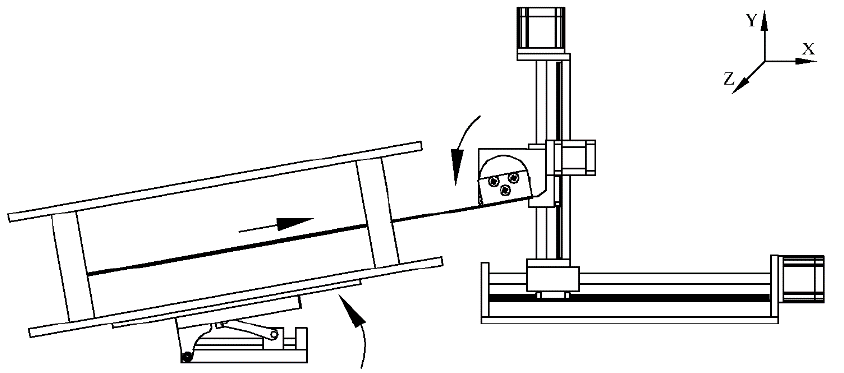
Figure 3. 3-DOF motion platform and flip platform coordinated movement.